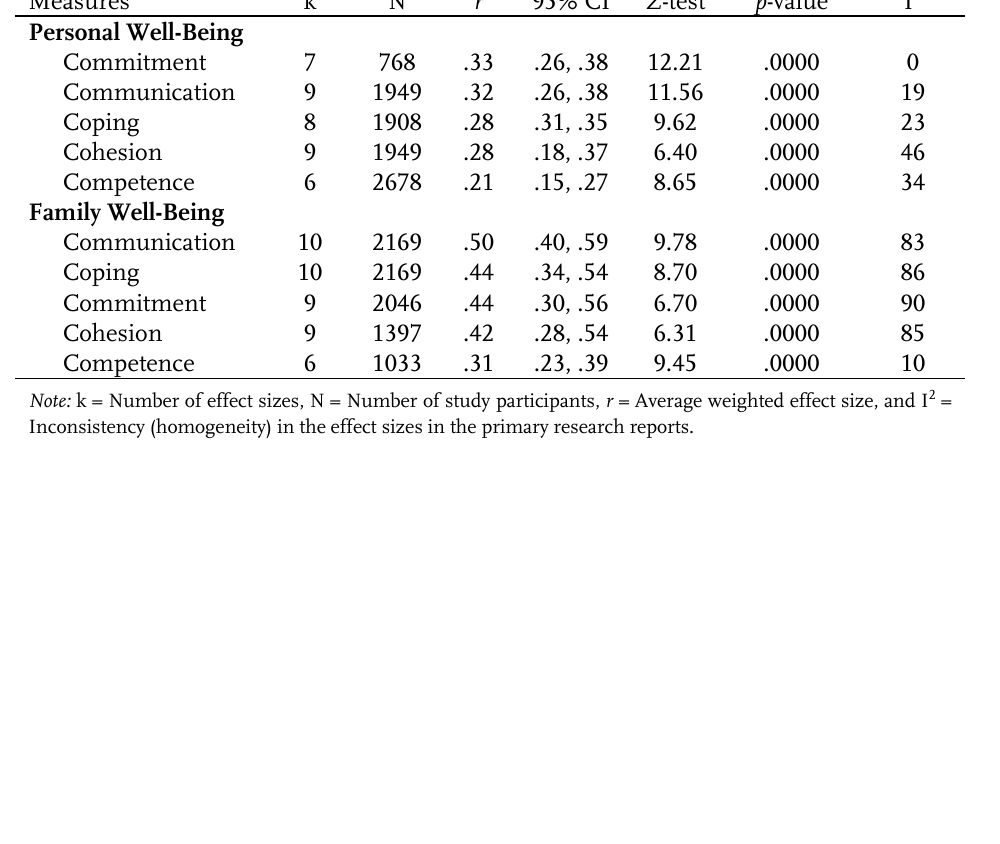
Table 4 : Average effect sizes and 95% Confidence Intervals (CI) for the relationships between the five family strengths dimensions and personal and family well-being